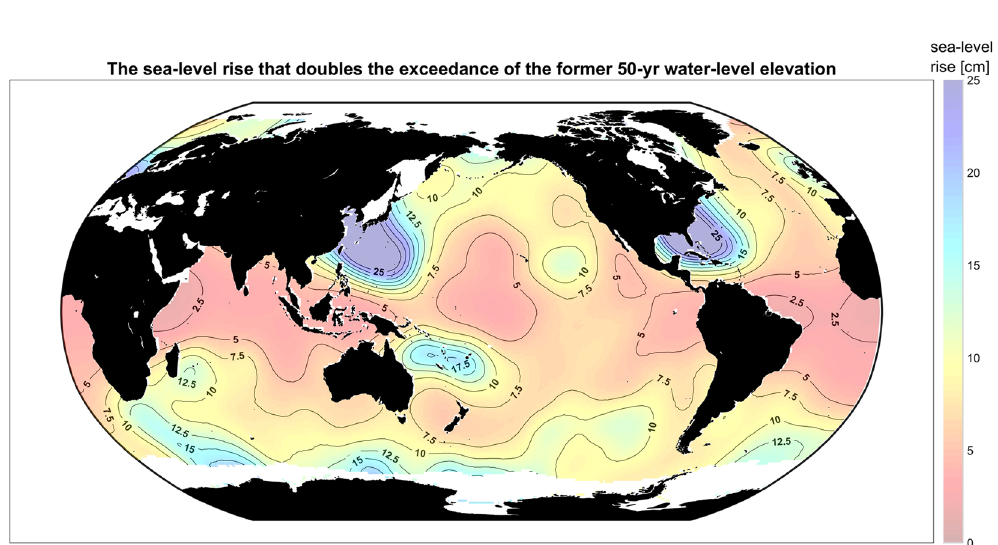
Figure 5. The upper bound of SLR that doubles the exceedance probability of the former 50-year water level. This SLR is the upper limit of a 95% confidence interval based on a Monte Carlo simulation of the GEV parameter estimates and their associated confidence bands (see Methods). Red areas represent regions particularly vulnerable to small amounts of SLR. The maps in this figure were made using Matlab 2016a (https:// www.mathworks.com/products/matlab/).